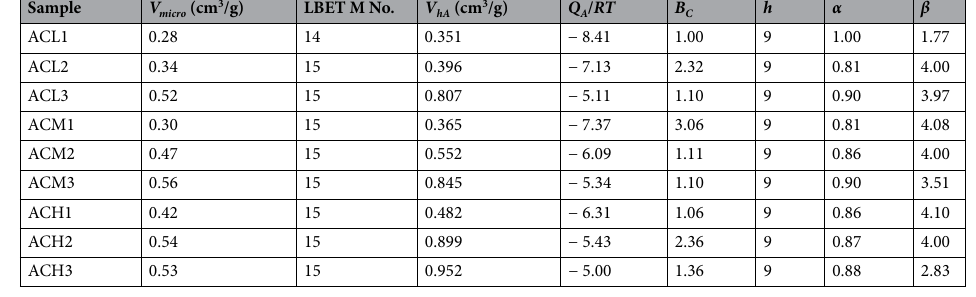
Table 2. Parameters characterizing the microporous structure of the activated carbons developed by chemical activation of Pine cones with KOH, obtained with different impregnation ratios and process temperatures, based on the analysis of CO 2 adsorption isotherms using the DR, LBET, and QSDFT methods.